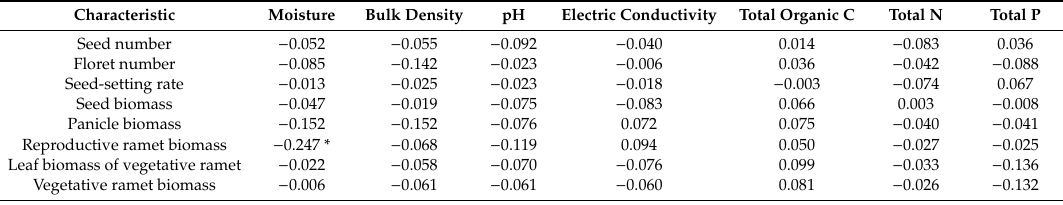
Table 3. Relationships between soil physicochemical properties and sexual reproductive characteristics as well as growth characteristics of vegetative ramets in the natural populations of Hierochloe glabra in 2018. Pearson’s correlation coe ffi cients are